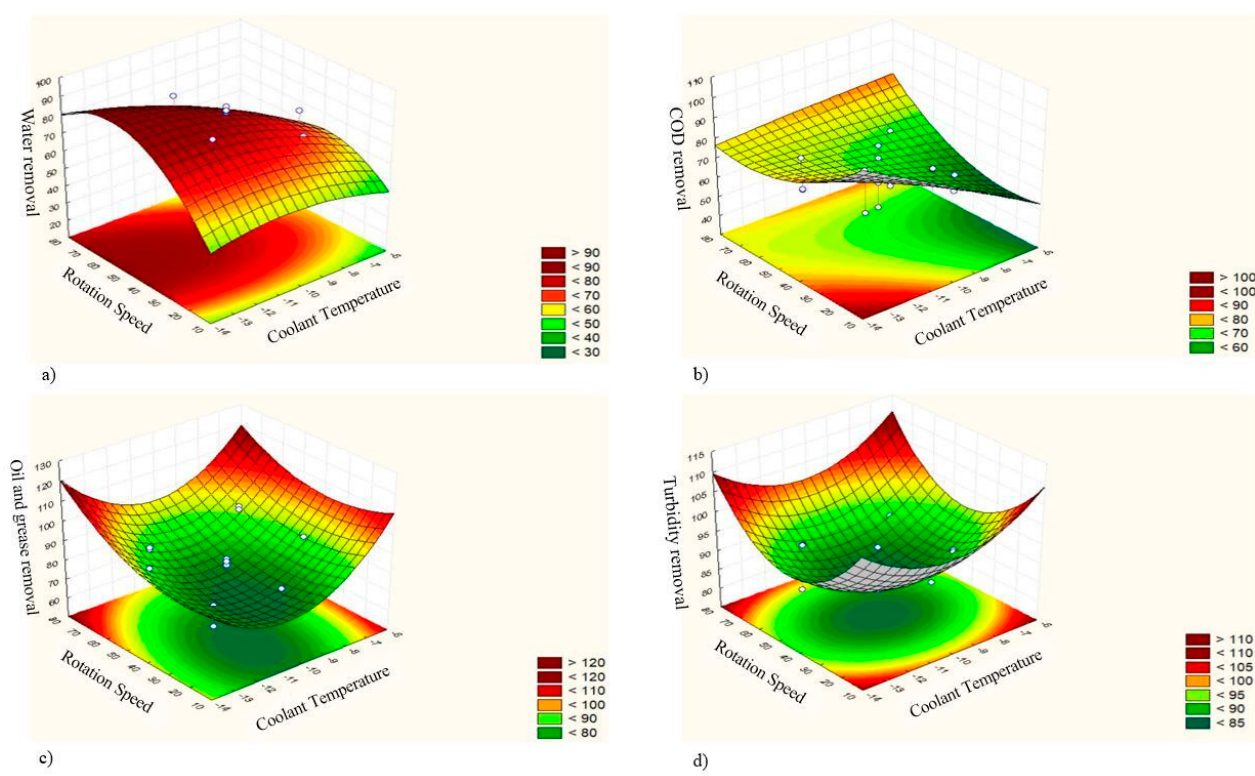
Figure 7. 3D surface plot of ( a ) water removal ( b ) COD removal ( c ) oil and grease removal ( d ) turbidity removal as a function of rotation speed and freezing time.